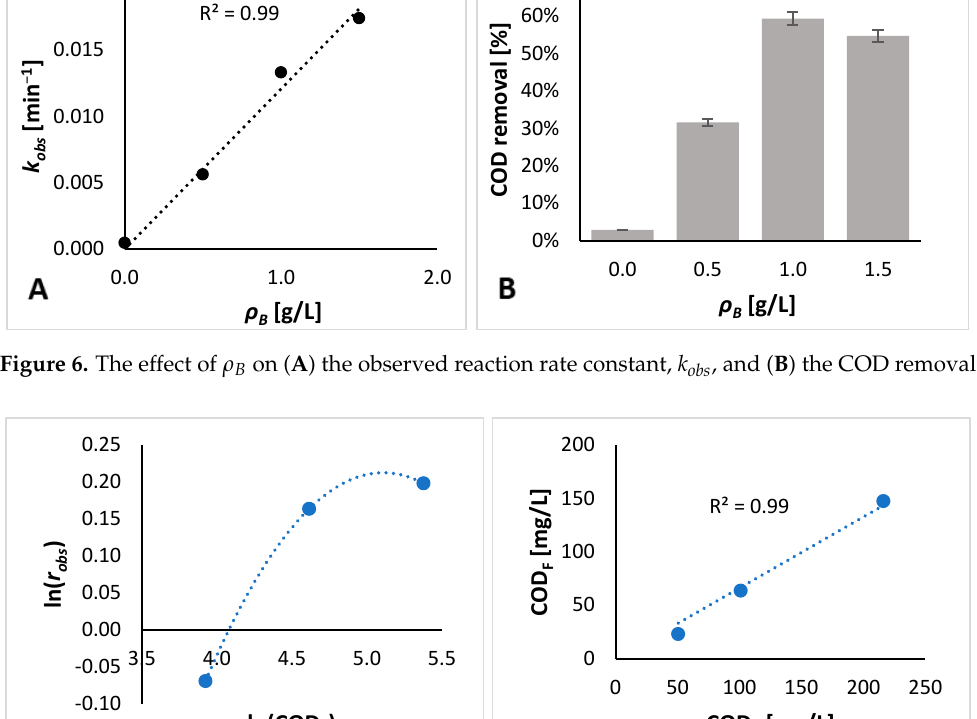
Figure 6. The effect of 𝜌 (cid:3003) on ( A ) the observed reaction rate constant, k obs , and ( B ) the COD removal.